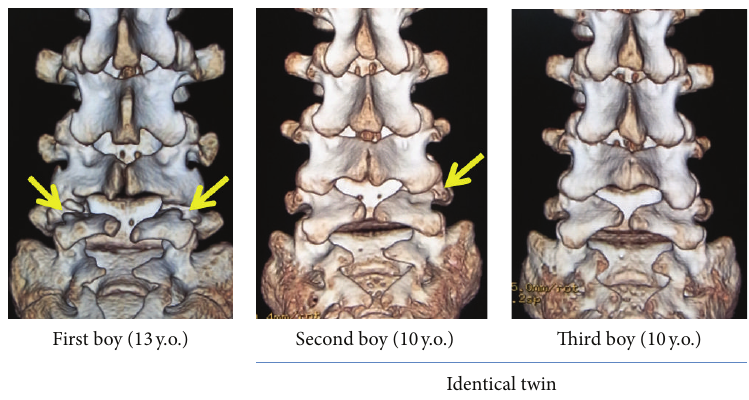
Figure 10: 3D-CT of Cases 1–3, all showing similar